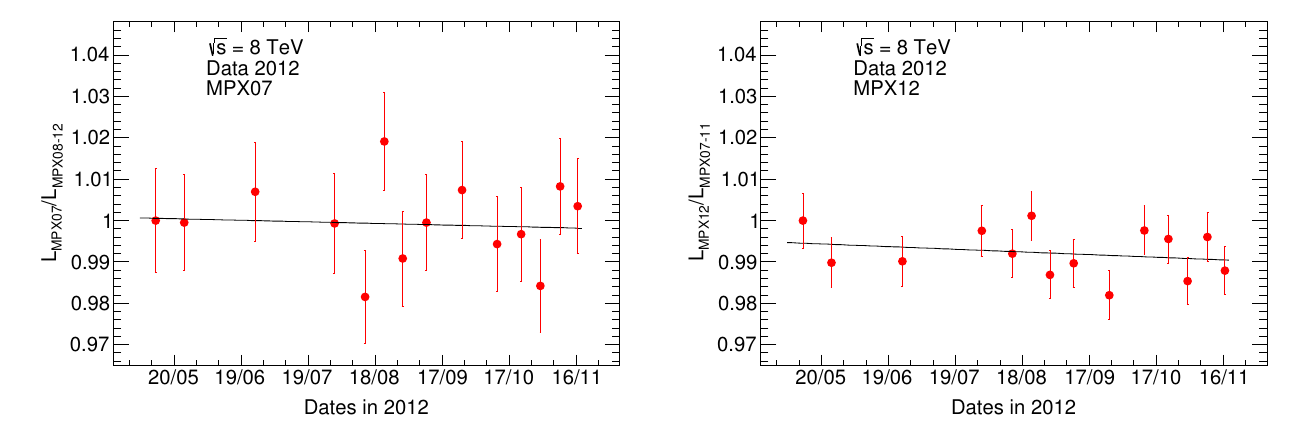
Figure 7. Time history of the luminosity ratio MPX/MPXav for two of the six MPX devices with lowest particle flux (MPX07-12) used for heavy blob (thermal neutron) counting. A linear fit is applied to determine the slopes. The 2012 data are divided into 14 time periods with an equal number of LBs. The data are scaled such that the value of the first bin is unity. The statistical error bars are shown. LHC fills from May to November 2012. Taken from Ref. [11]. Table 4. Slope of time history of the luminosity ratio MPX/MPXav for the six MPX devices